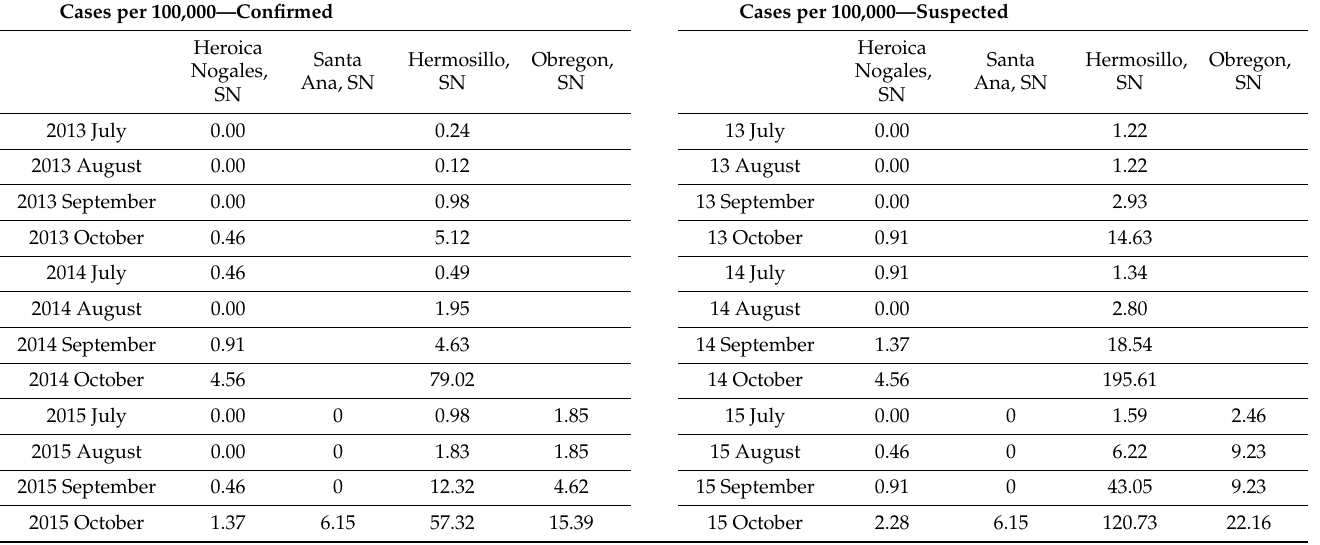
Table 2. Dengue incidence by municipality during and one month following the end of the sampling period for all sites. Confirmed cases (left) and suspected cases (right). No data presented for Tucson, AZ or Nogales, AZ where no locally acquired dengue cases were reported during the study period